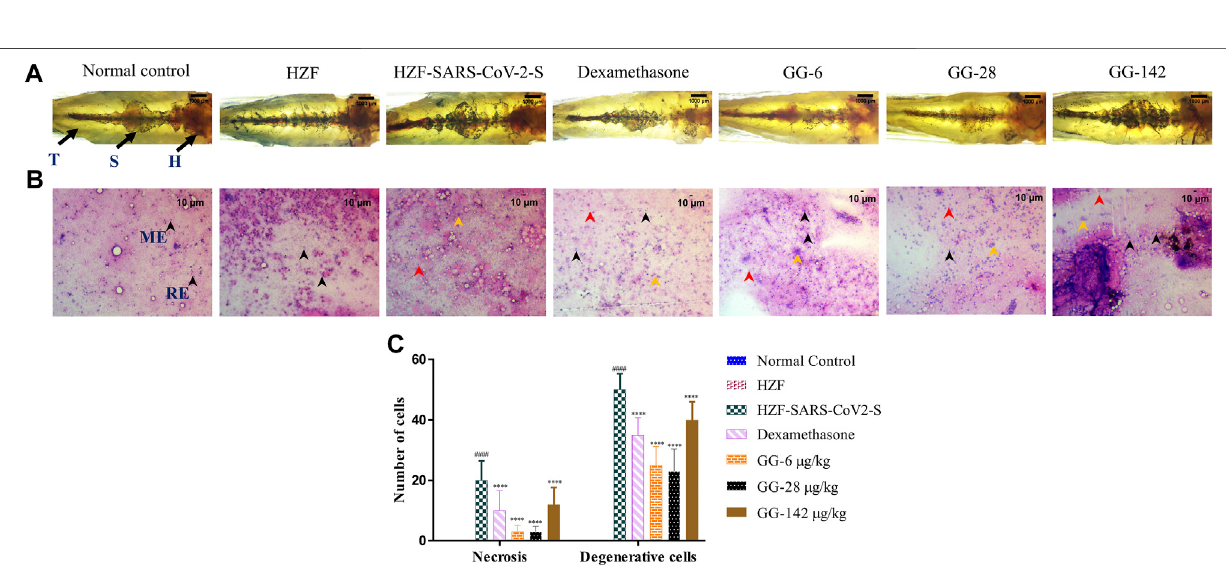
Frontiers in Pharmacology |